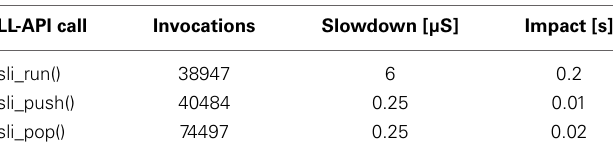
Table 2 | Simplified Hill-Tononi model as a benchmark for PyNEST and CyNEST.